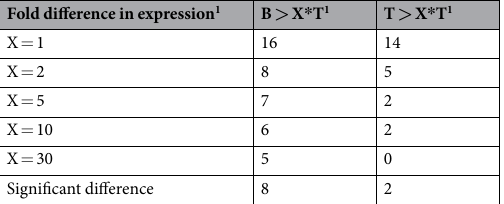
Fold difference in expression 1 B > X * T 1 T > X * T 1